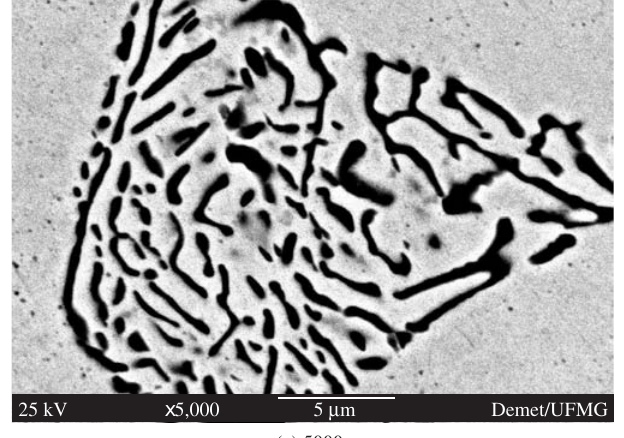
Figure 9. Grain size evolution during ECAP.